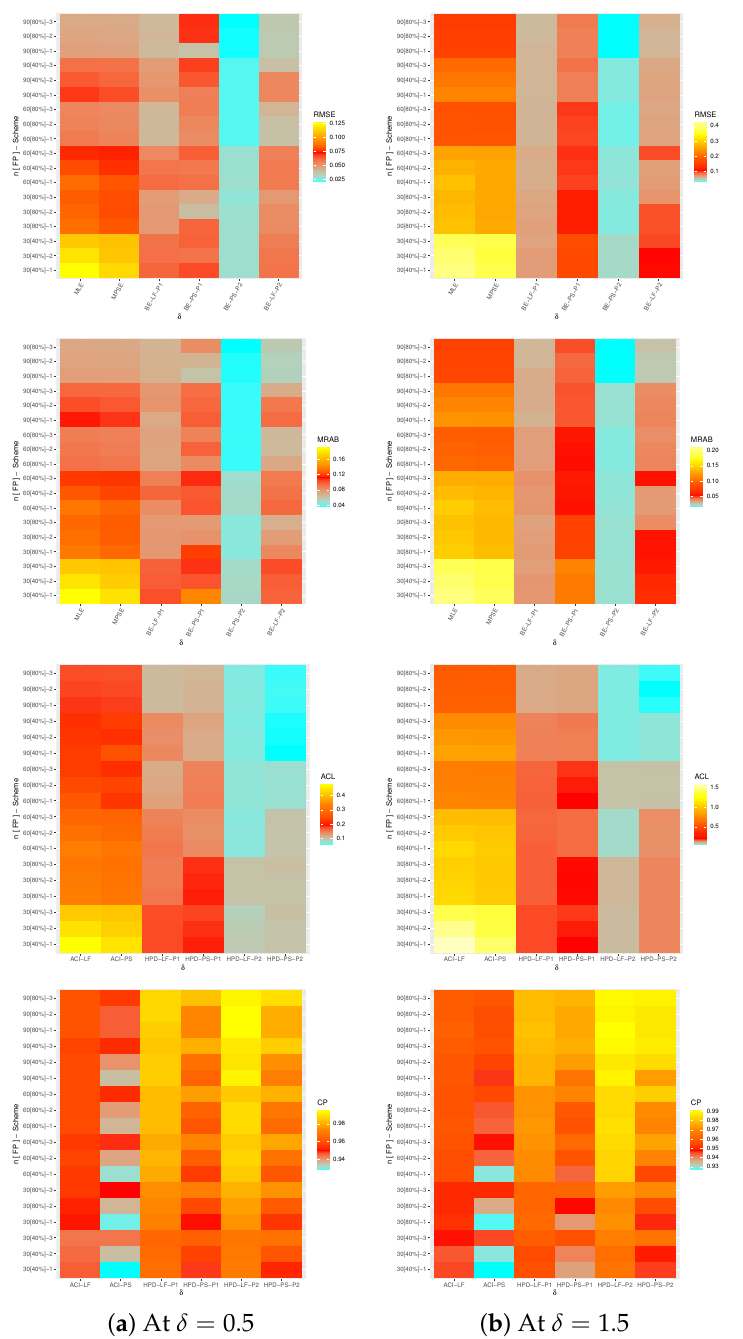
Figure 1. Heatmap plots for the simulation outputs of δ